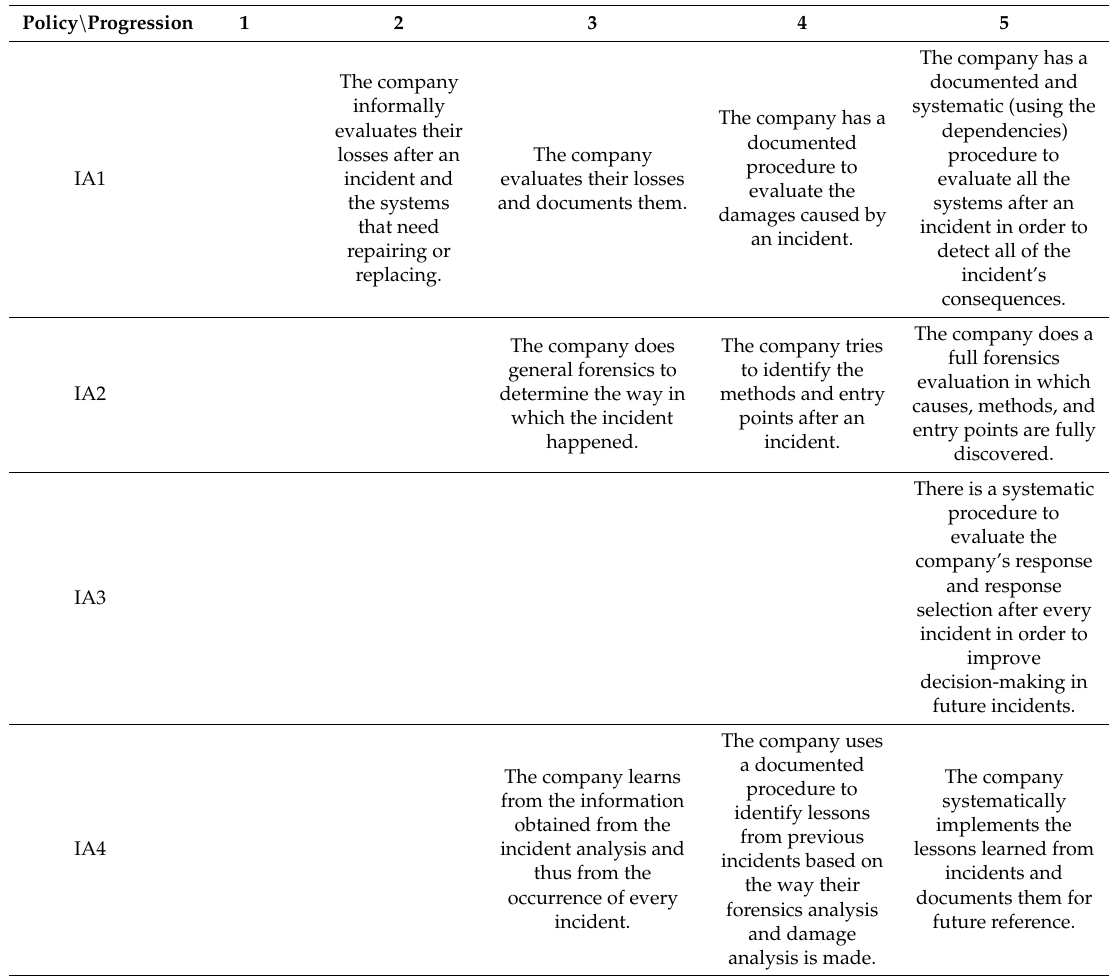
Table 16. Incident analysis policies’ progression